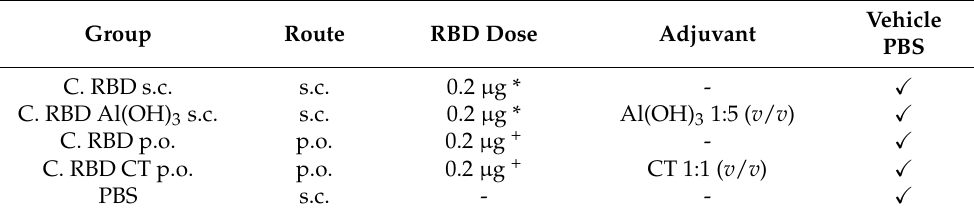
Abbreviations: C. RBD: Chlamydomonas -made RBD given in the form of algae total soluble protein extract; s.c.: subcutaneous; p.o.: per os; DW: Dried Weight; CT: Cholera toxin. * as soluble antigen. + encapsulated in algae